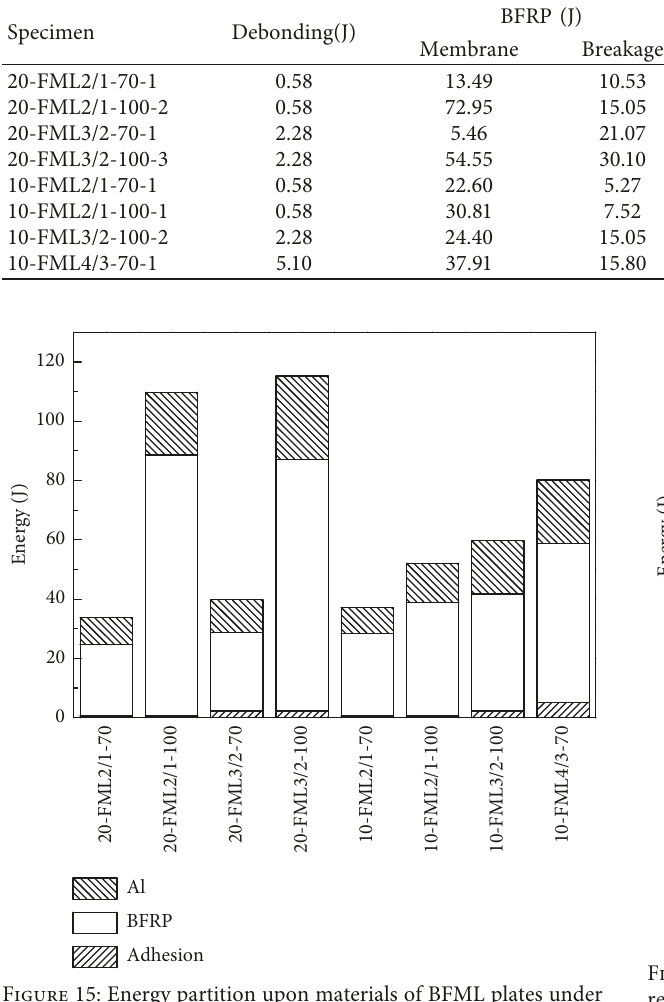
Table 8: Energy partition of BFML plates under drop-weight impact.